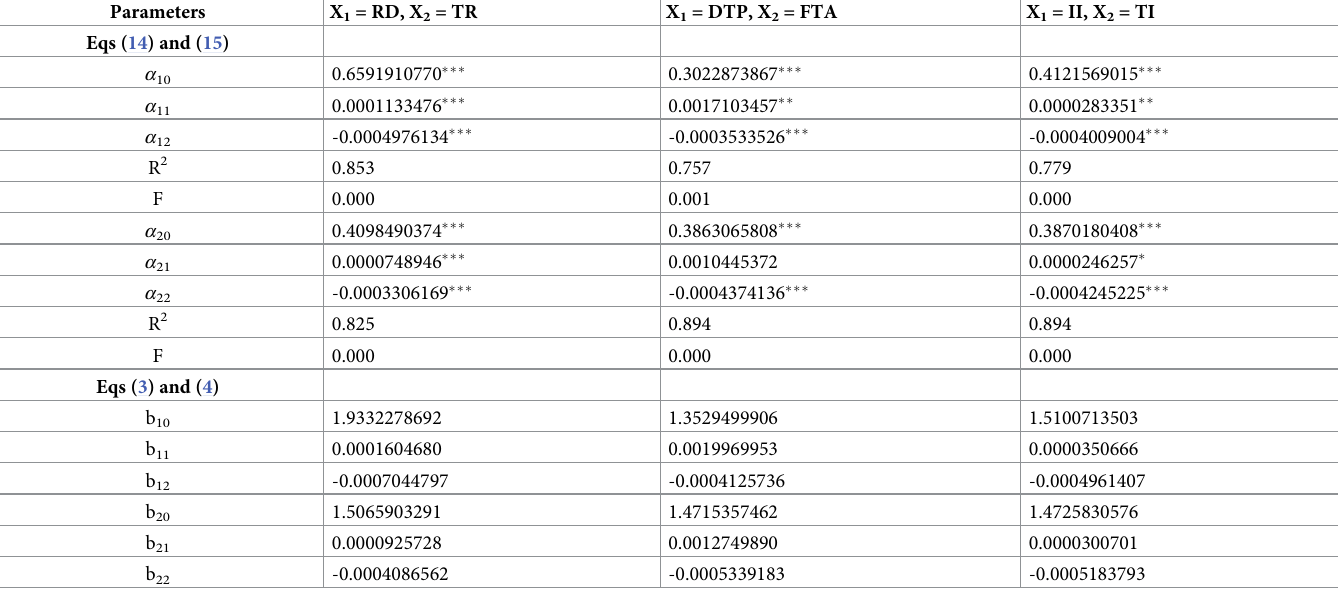
Table 8. Parameter estimation and calculation results with the log-integral method for the Lotka-Volterra model. Parameters